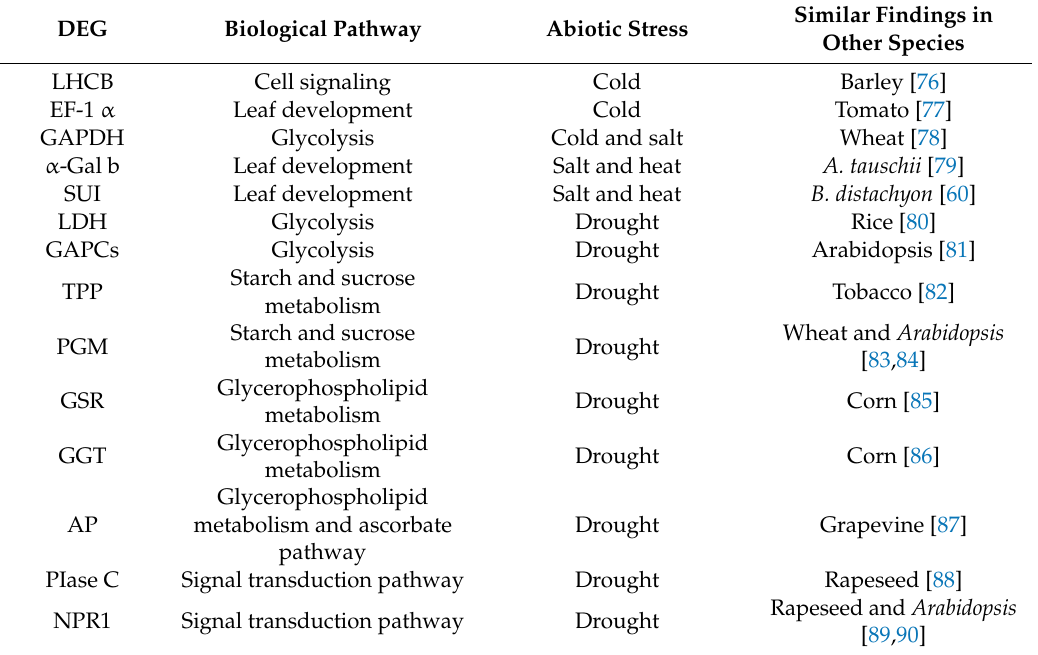
Table 2. Di ff erentially expressed genes (DEG) putatively involved in abiotic stress tolerance in L. multiflorum